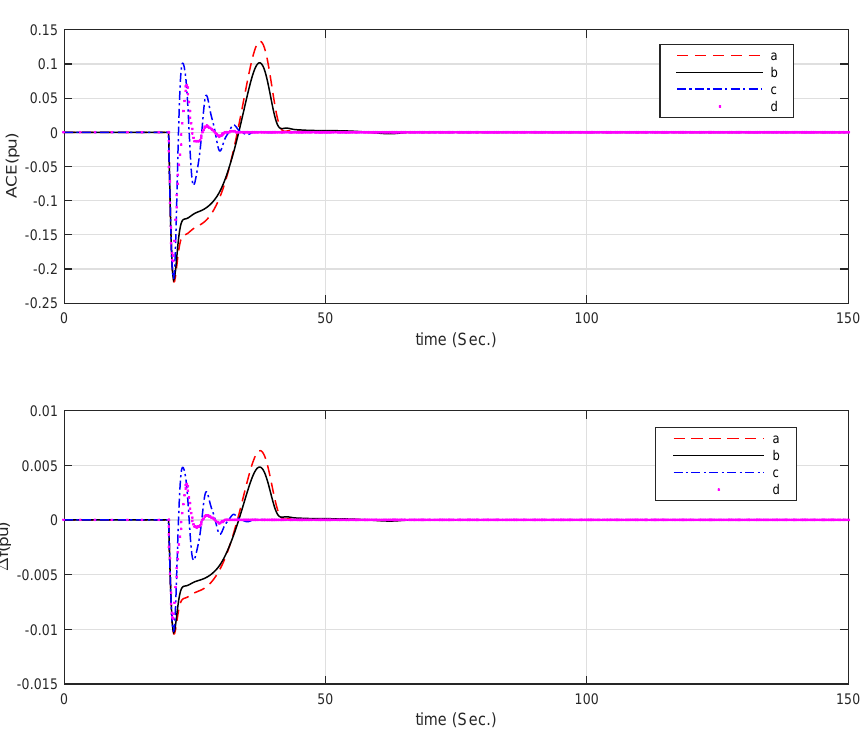
Figure 6. Frequency deviation and control error responses of one-area deregulated LFC scheme with h 1 ( t ) = 0 and different K P , K I and time-varying h 2 ( t )